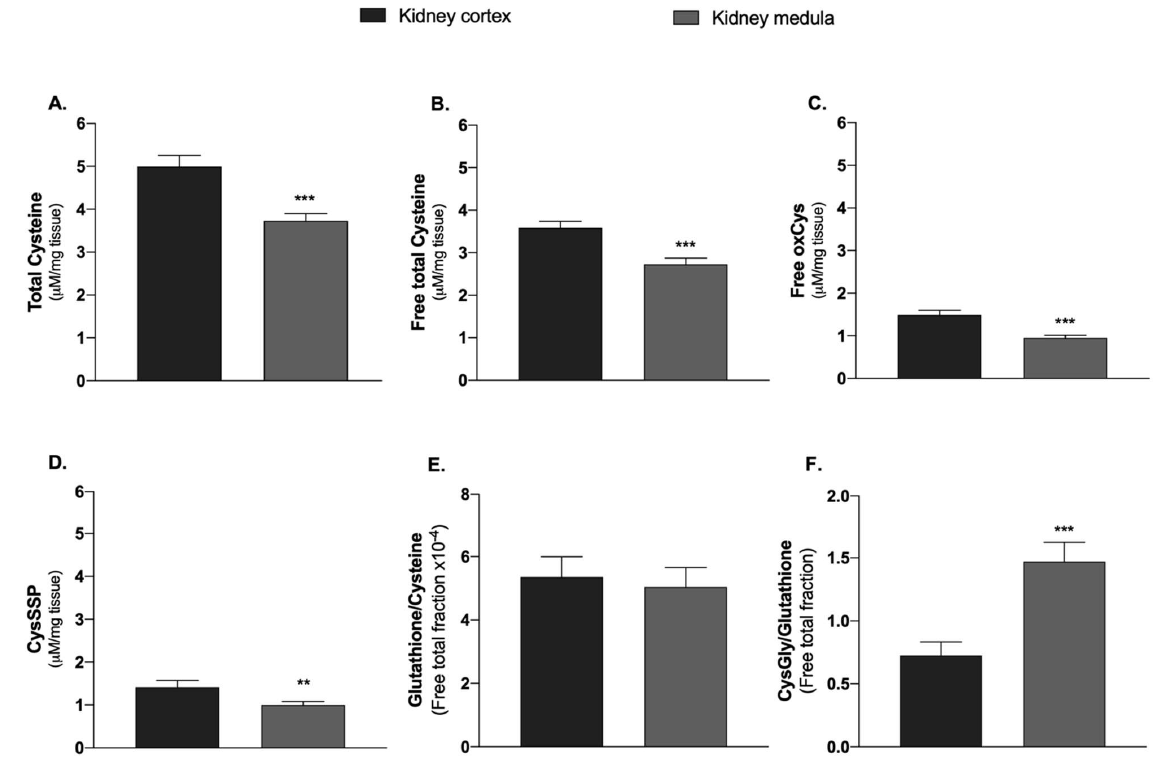
Figure 4. Cysteine-related thiols in the kidney cortex and kidney medulla. ( A ) Total cysteine. ( B ) Free total cysteine. ( C ) Free oxidized cysteine. ( D ) Cysteinylated protein. ( E ) Free total glutathione/Free total cysteine (Glutathione synthesis). ( F ) Free total cysteinylglycine/Free total glutathione (Glutathione catabolism). Data are presented as the mean ± standard error of the mean. Wilcoxon matched-pairs signed rank test, ** p < 0.01 and *** p < 0.001. CysGly: cysteinylglycine; CysSSP: cysteinylated proteins; oxCys: oxidized cysteine.